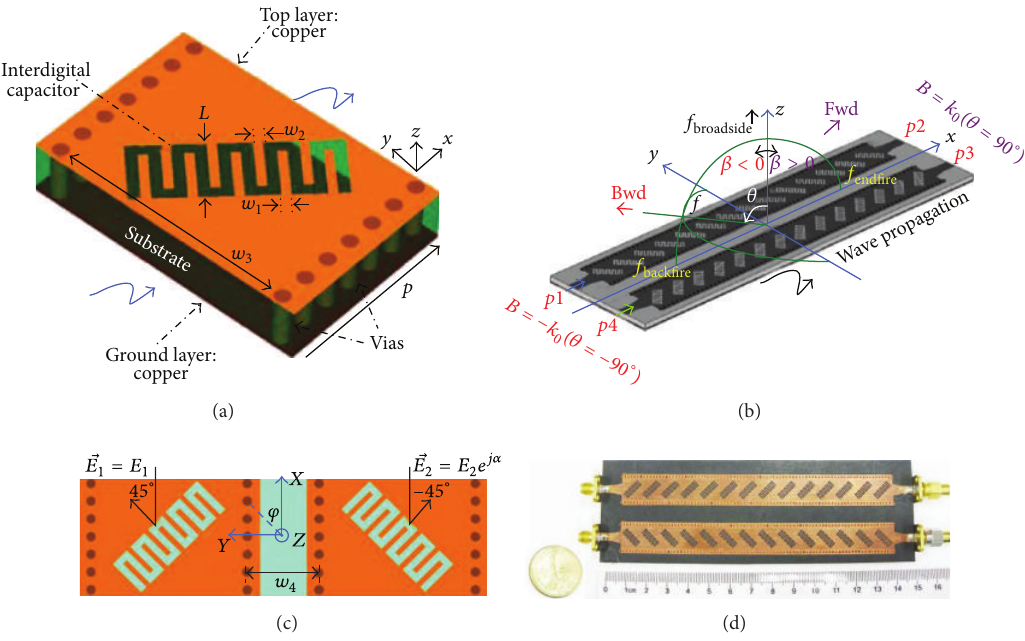
Figure 10: Polarization reconfigurable CRLH-SIW antenna. (a) Single radiating element. (b) Two-element unit cell of the whole structure. (c) Overall LW antenna prototype. (d) fabricated antenna (with permission from